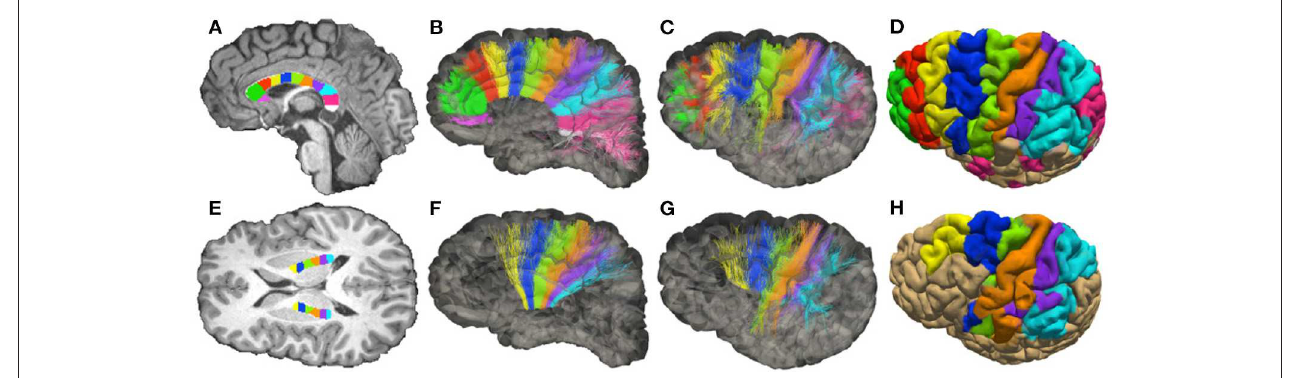
FIGURE 3 | Topology of fibers in the Corpus Callosum (CC) and posterior limb of the internal capsule (PIC), reconstructed with DW-MRI tractography of a single healthy volunteer. (A) Subdivision of the mid-sagittal section of the CC in 11 sectors (corresponding to ROIs), see Supplementary Figure 9 . (B,C) Streamlines colored according to the corresponding ROIs (medial and lateral views of the hemisphere). (D) Projection of the streamlines onto the pial surface. (E) Subdivision of PIC in 6 sectors (ROIs). (F,G) Streamlines colored according to the corresponding ROIs (medial and lateral view of the hemisphere). (H) Projection of the streamlines onto the pial